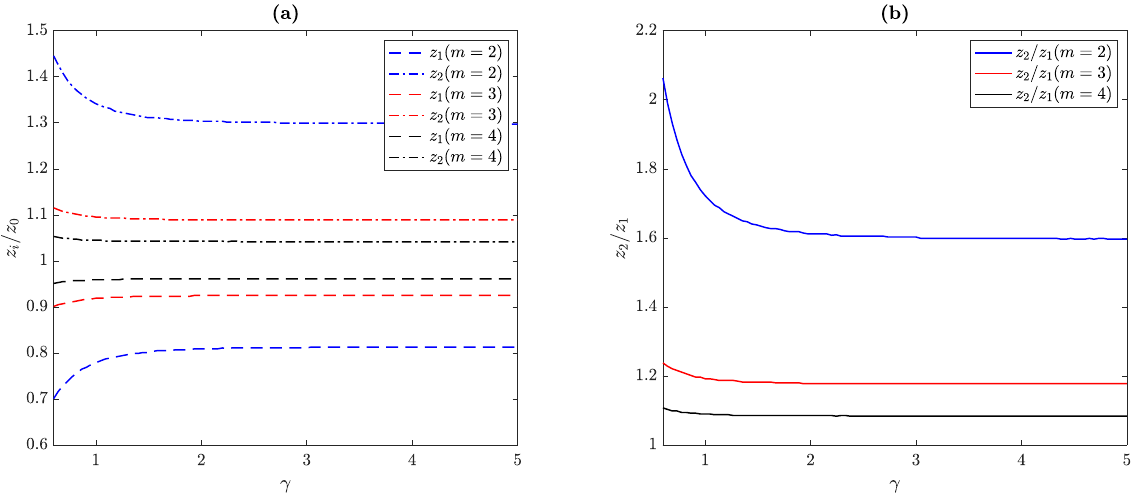
Figure 5. ( a ) Normalized focal distances and ( b ) focal distance ratio as a function of the γ